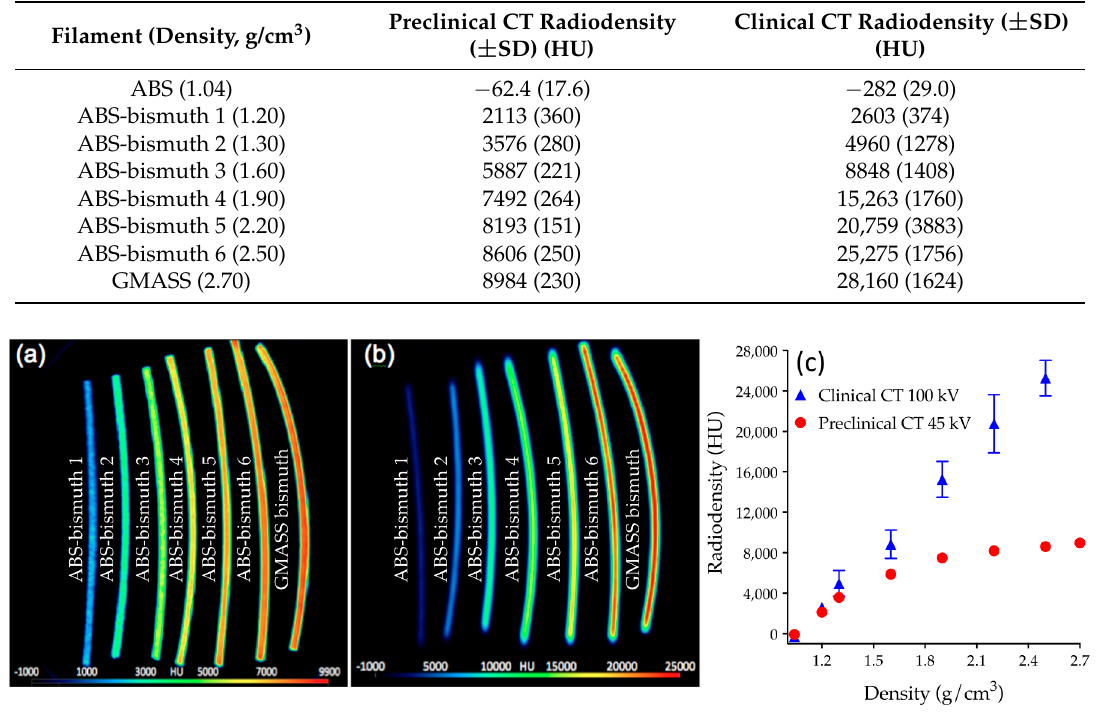
Figure 1. Radiodensities of 3D-printed filaments: Reconstructed image slice of preclinical CT ( a ) and clinical CT ( b ) data of ABS-bismuth and GMASS filaments with colorimetric representation of radiodensity; ( c ) Volume of interest data of radiodensities were plotted as a function of filament density for ABS, ABS-bismuth, and GMASS filaments from both preclinical and clinical CT scans. As expected, the radiodensity increased with the increasing concentration of